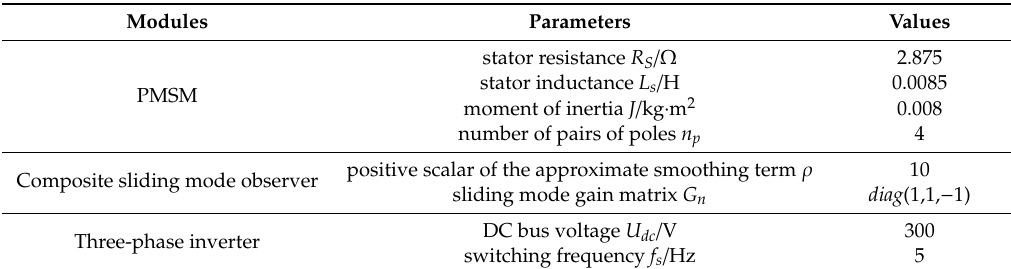
Table 1. The specific simulation parameters.